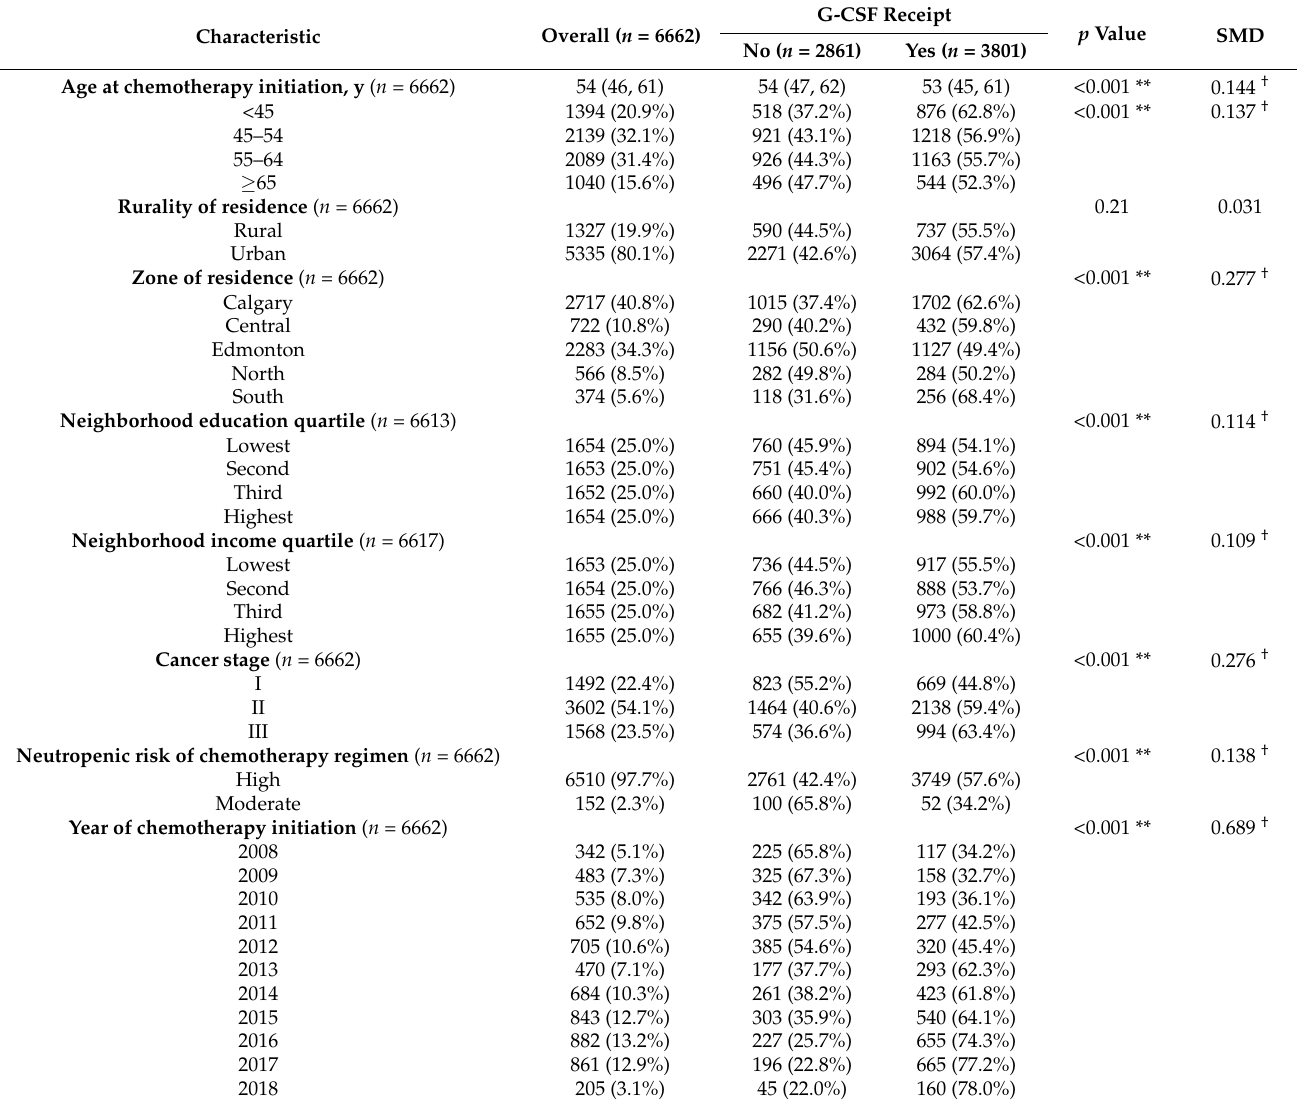
Table 1. Baseline characteristics of the study population, stratified by G-CSF